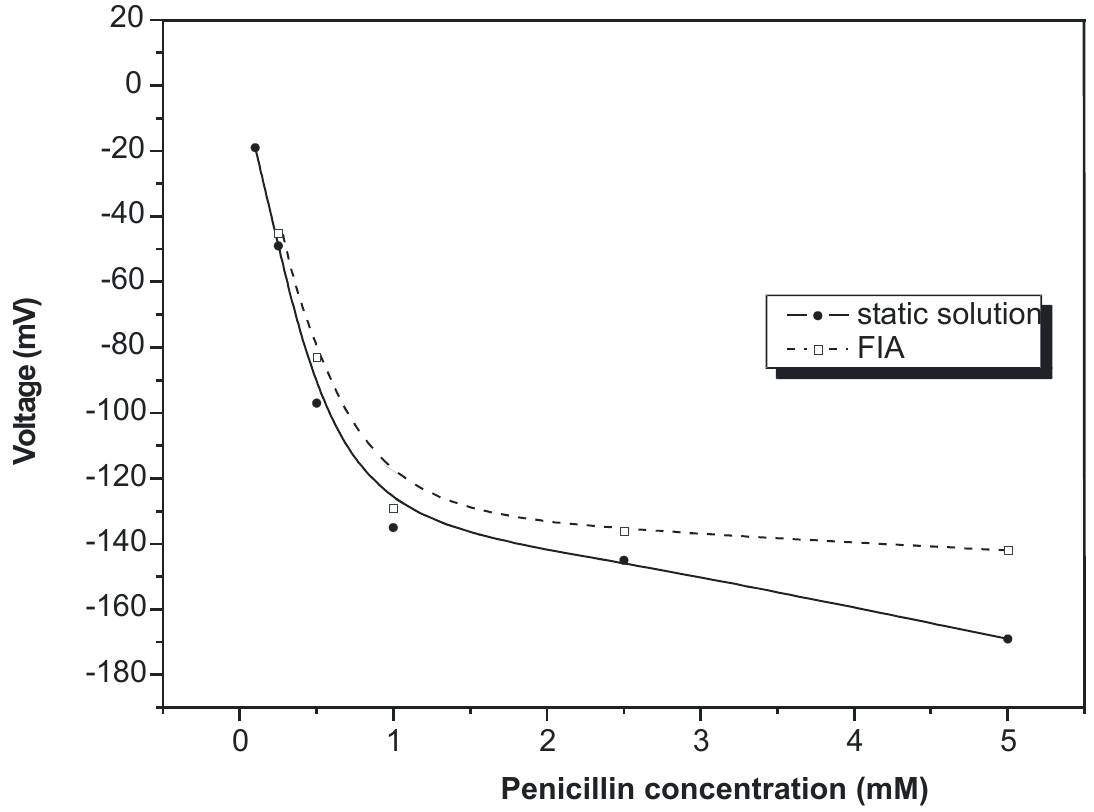
Figure 6. Calibration curves of the EIS penicillin biosensor evaluated from static and FIA measurements,